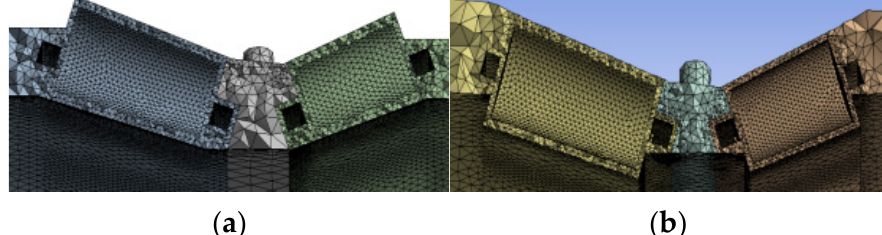
( b ) Figure 6. Simplified double-row TBR models. ( a ) Outer ring rib structure; ( b ) Inner ring rib struc- ture. The internal flow field analysis model of the bearing is extracted using the ANSYS Design Modeler, as shown in Figure 7. Six oil ports are uniformly distributed on the outer ring of the bearing, where two oil ports are used for oil filling, and the other four are pressure outlets. The pressure is atmospheric pressure. ( a ) ( b ) Figure 7. Internal flow field analysis models of the bearings. ( a ) Outer ring rib structure; ( b ) Inner ring rib structure. 4.2. Meshing The double-row TBR is composed of large/small rollers, an inner ring, an outer ring, a cage, and other components, which give it a relatively complex structure. The hexahe- dral mesh has high accuracy and a small number of nodes, but for complex models similar to bearings, the tetrahedral mesh has stronger adaptability and can meet the complex structure of any shape. A certain degree of optimization will be carried out during the mesh generation process. The mesh size and node density are also easier to control, so higher quality meshes can be generated, and the mesh quality is often better than that of